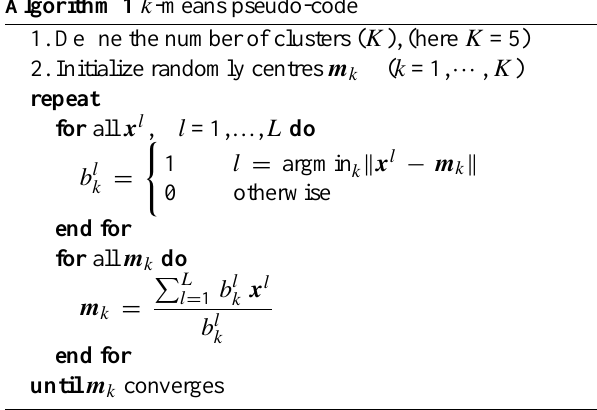
Algorithm 1 k -means